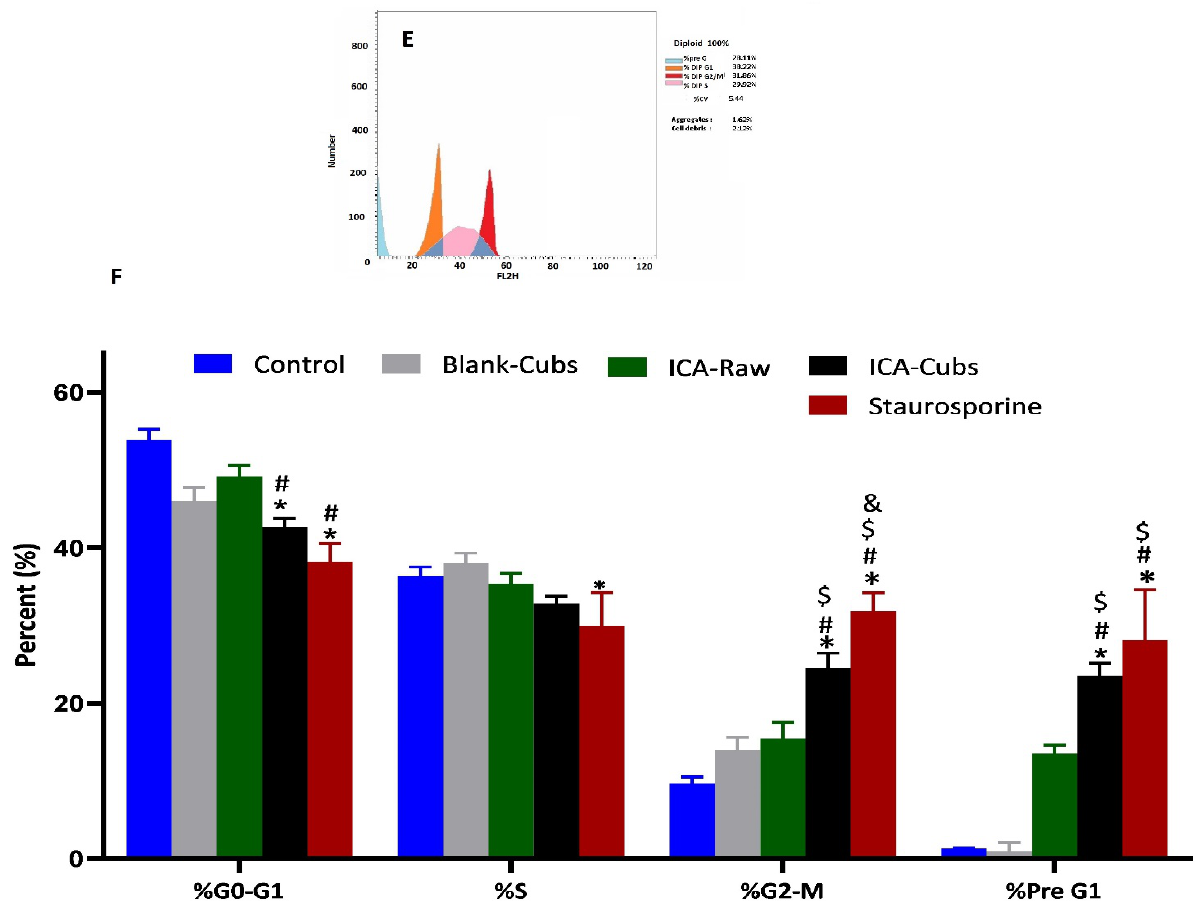
Figure 9. Flow cytometric analysis of the cell cycle arrest,(A) Skov-3 cells without treatment, then after treatment with (B) the blank-Cubs,(B) ICA-raw, (C) ICA-Cubs, (D)Staurosporine against the SKOV-3 cell line. (E) Bar diagram of the different cycle phases. Data are expressed in (F) as the mean ± SD (n = 4 runs). * represents a significant difference when compared with untreated cells (control) ( p < 0.05), whereas # represents a significant difference when compared with the blank-Cubs ( p < 0.05) and $ represents a significant difference when compared with the ICA-raw ( p < 0.05) and & represents a significant difference when compared with the ICA-Cubs ( p < 0.05).